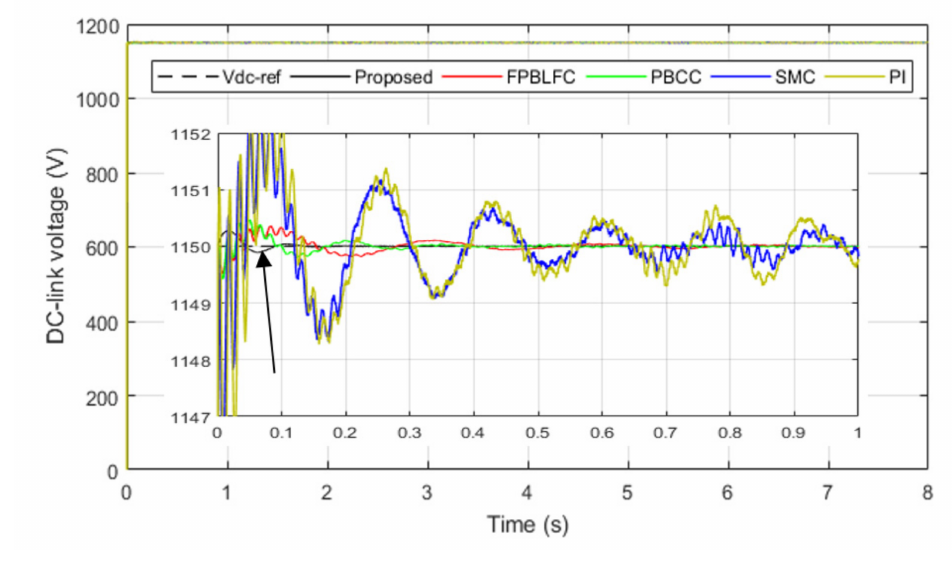
Figure 8. DC-link voltages.